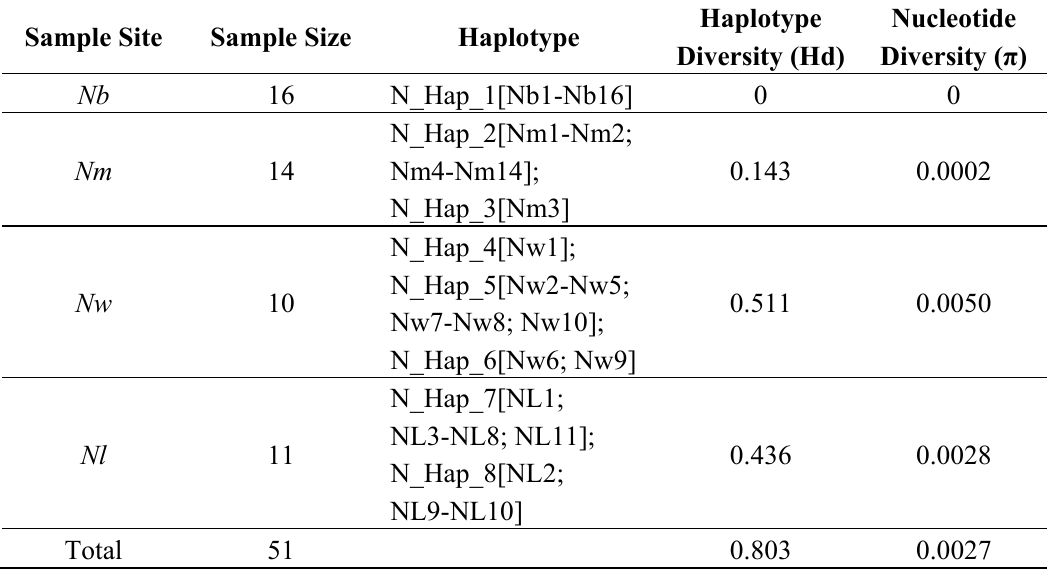
Table 1. Sample sites, sample sizes and haplotype distributions of Neodiaptomus schmackeri